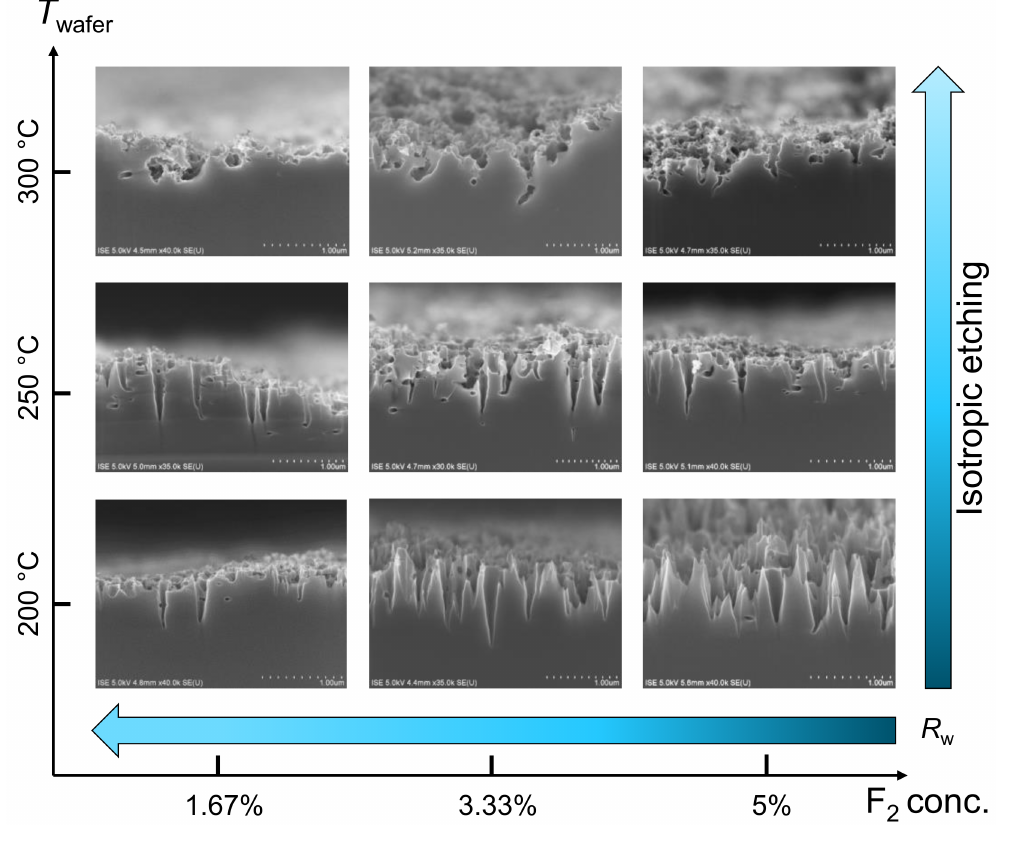
Figure 7. Cross-sectional SEM images of c -Si surfaces etched using constant velocity ( v = 2 mm / s) using di ff erent combinations of F 2 concentration σ F and temperature of the substrate T wafer . The direction of the arrows represents an increasing value of R w . The arrows represent an increasing value of R w for decreasing σ F , whereas an increasing degree of isotropic etching for an increasing T wafer